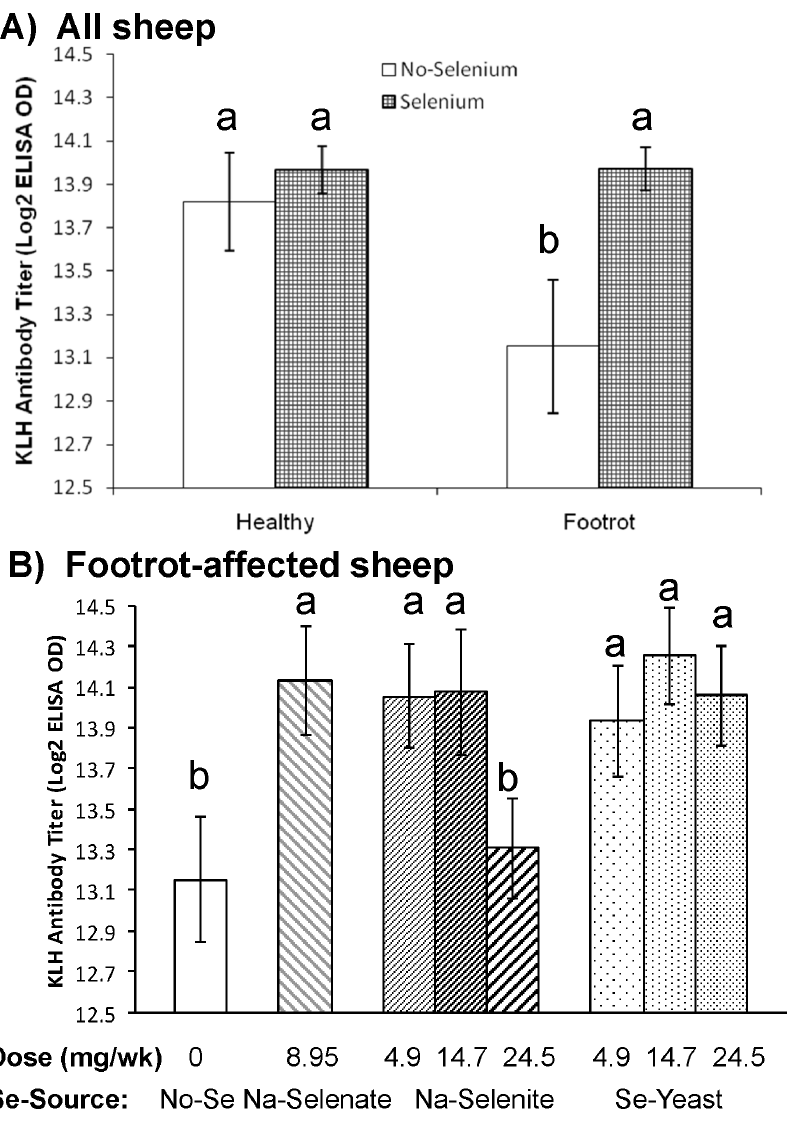
Figure 10. The effect of Se-source and dosage on antibody titers to keyhole limpet hemocyanin (KLH). Antibody titers to keyhole limpet hemocyanin (KLH) were assessed after 60 wk of Se supplementation in healthy and footrot (FR)-affected sheep receiving no Se treatment, Na- selenate at a dosage rate of 8.95 mg Se/wk per ewe, or Na-selenite and Se-Yeast at 4.9, 14.7, or 24.5 mg Se/wk per ewe for 62 wk. A) Weekly oral Se drenching improved KLH antibody titers in FR-affected ewes to titers that were similar to healthy ewes receiving no Se or healthy ewes receiving Se treatment. B ) In FR-affected ewes, KLH antibody titers were greater in all Se-supplemented groups compared with the non supplemented group with the exception of the 24.5 mg/wk Na-selenite group. Different superscripts indicate group differences at P #